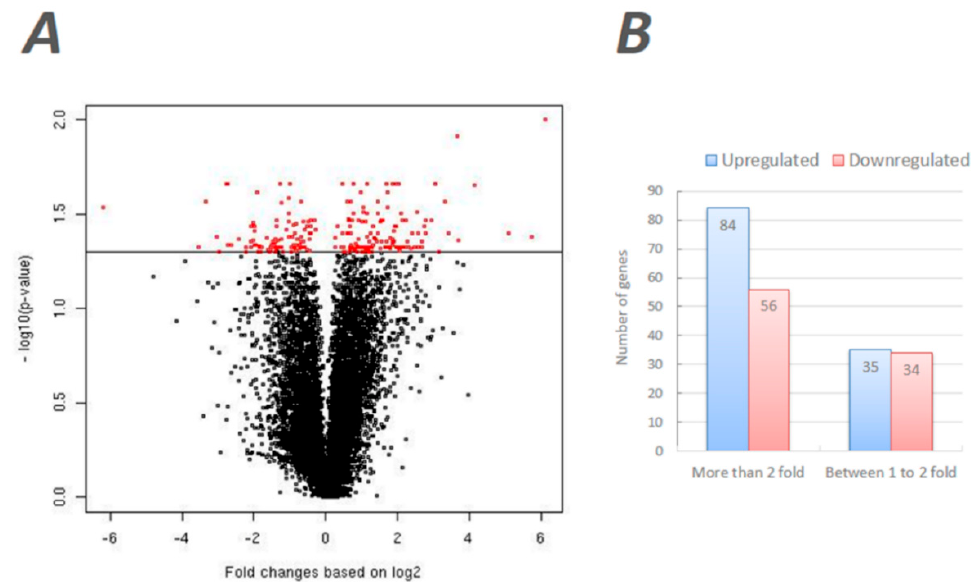
Figure 1. Microarray gene analysis of T37 and RED testes transcriptomes. ( A ) Volcano plot of normalized fold changes of gene expressions ( x -axis) with the normalized p -values ( y -axis) of differential expression of the corresponding genes between T37 and RED. The red dots represent the differentially expressed genes, while the black dots are not significant. The 119 genes (left side to 0) and the 90 genes (right side to 0) are positively and negatively expressed in T37 relative to RED respectively. ( B ) Relative expression levels in T37 testes in comparison to RED testes.